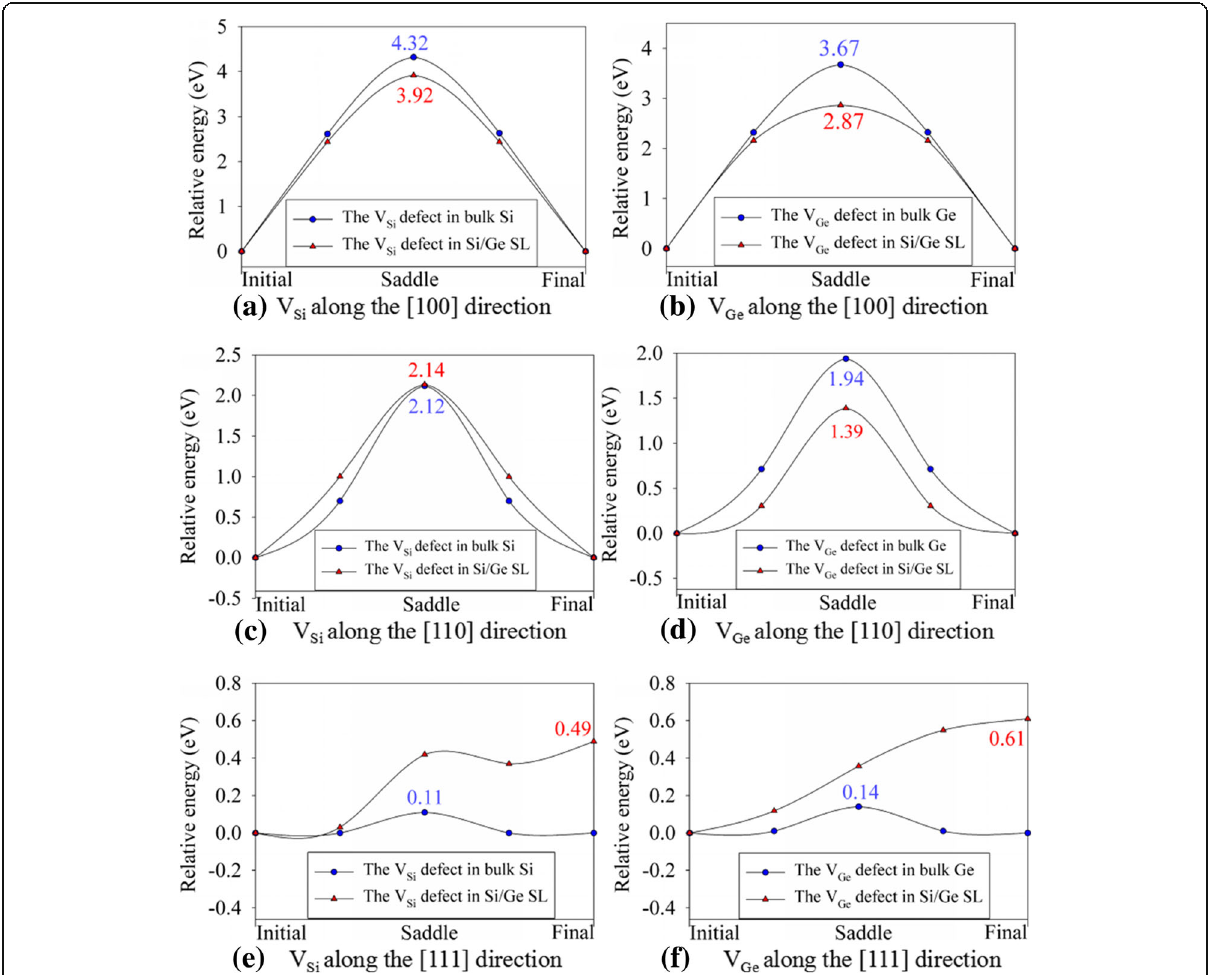
Fig. 6 The migration barrier of silicon vacancy (V Si ) and germanium vacancy (V Ge ) defects obtained by a cluster nudged elastic band method. a V Si along the [100] direction; b V Ge along the [100] direction; c V Si along the [110] direction; d V Ge along the [110] direction; e V Si along the [111] direction; f V Ge along the [111]